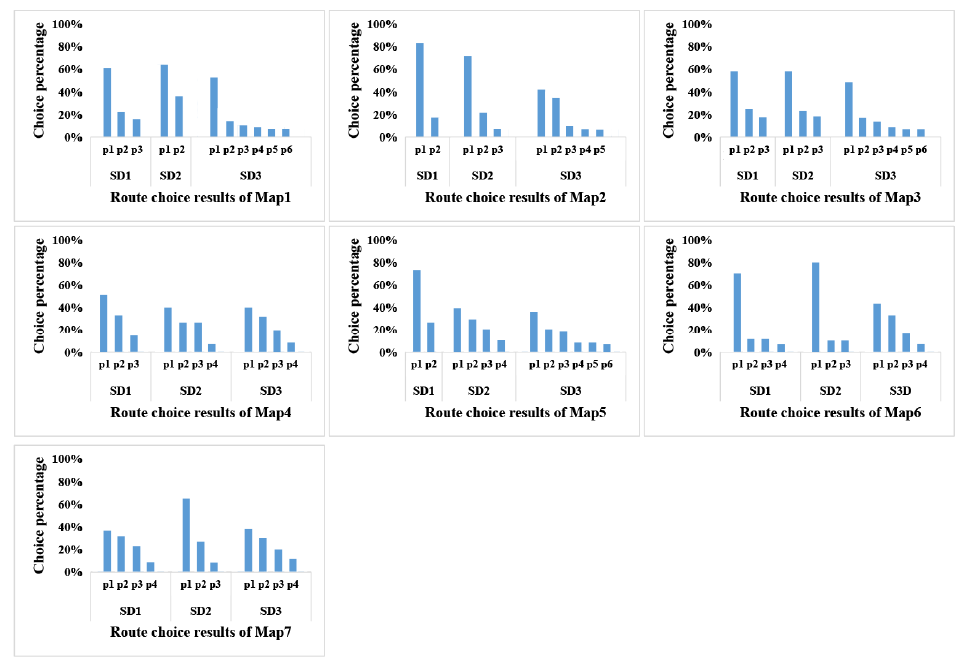
Figure 3. Route choice results for the baseline maps.